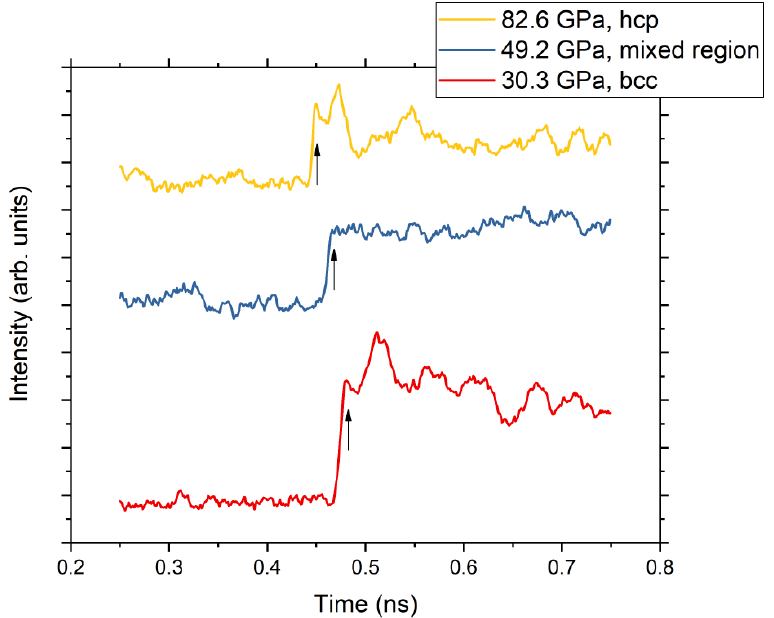
Figure 3. bcc-hcp transition observed by PA time domain measurements for Fe10Si. The signal shows a sharp, well-defined initial acoustic echo above and below the transition region observed by XRD